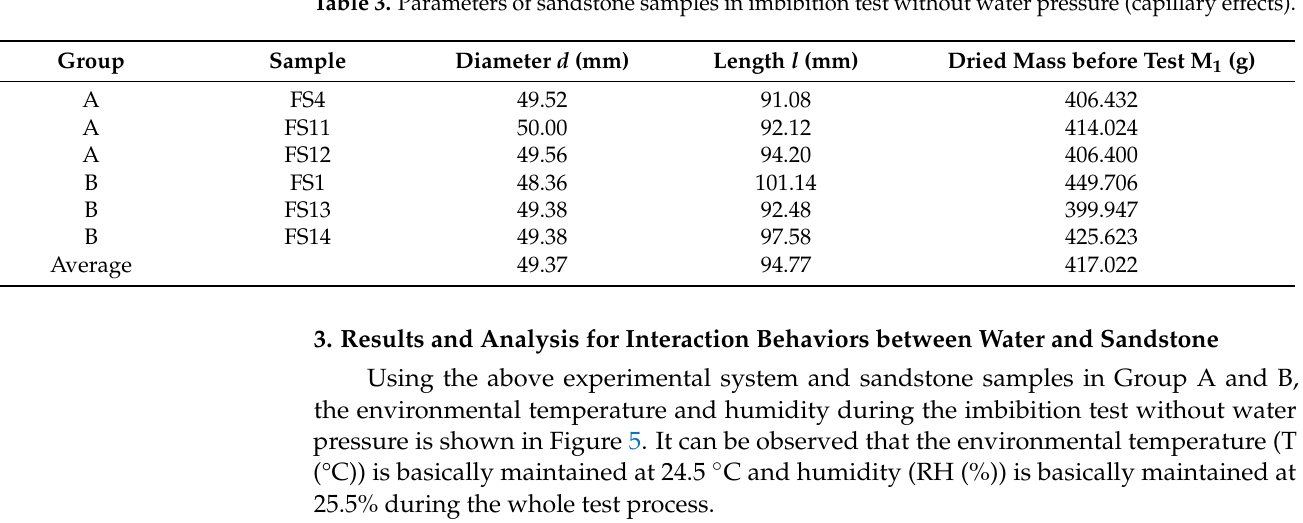
Table 3. Parameters of sandstone samples in imbibition test without water pressure (capillary effects).